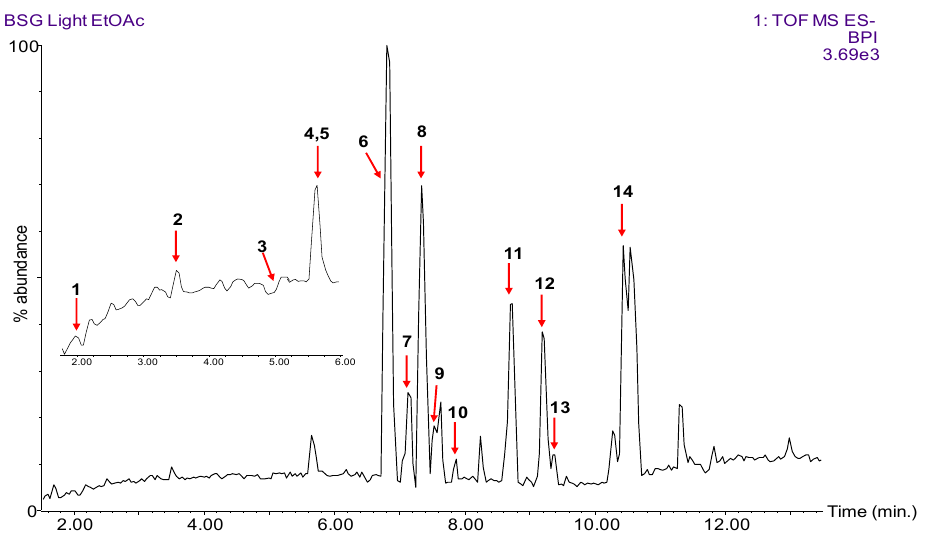
Figure 2. HPLC-Q-ToF (quadrupole time-of-flight) chromatogram of EtOAc fraction of BSG L showing the polyphenols (peaks 1–14) as assigned in Table 2. Shown in the inset is a close-up figure for the minor peaks 1–5. The elution time for peaks 1, 3 and 4 are demonstrated in their extracted ion chromatograms in Supplementary Figure S1. Table 2. HPLC-Q-ToF identification of polyphenols in the ethyl acetate fraction of hydrolysed light BSG. Peak RT No.